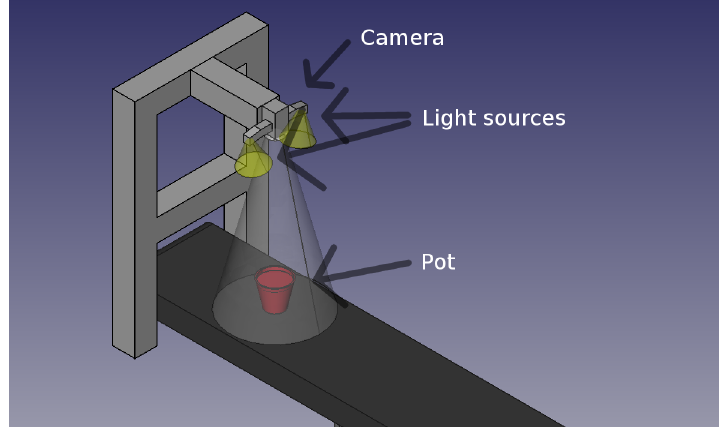
Figure 2. Sketch of recording camera setup and light source